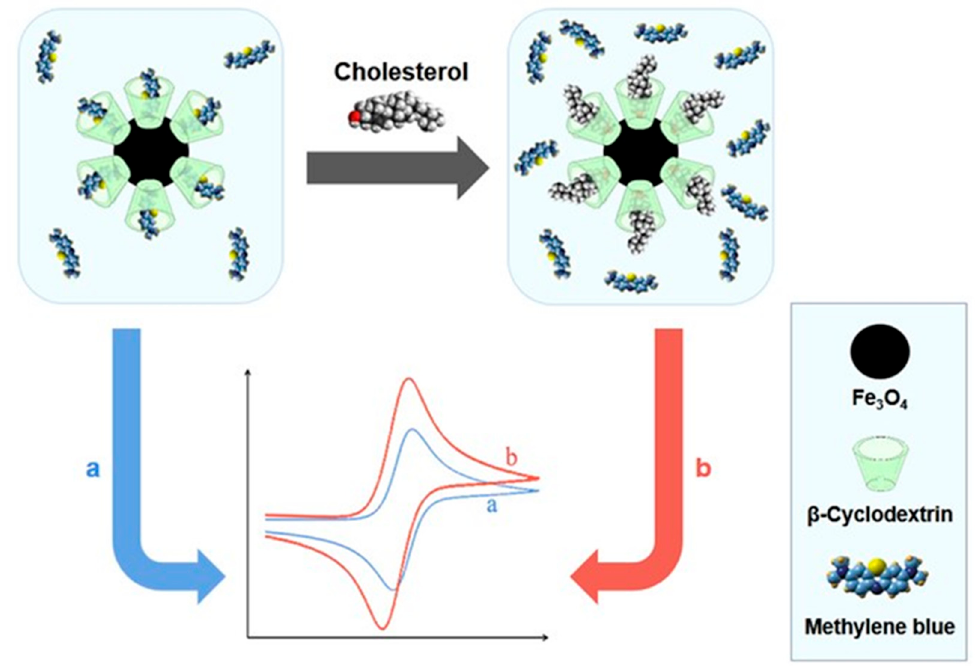
Figure 4. β -Cyclodextrin/Fe 3 O 4 nanocompositefor Cholesterol Sensor. Reprinted with permission from Ref. [47].